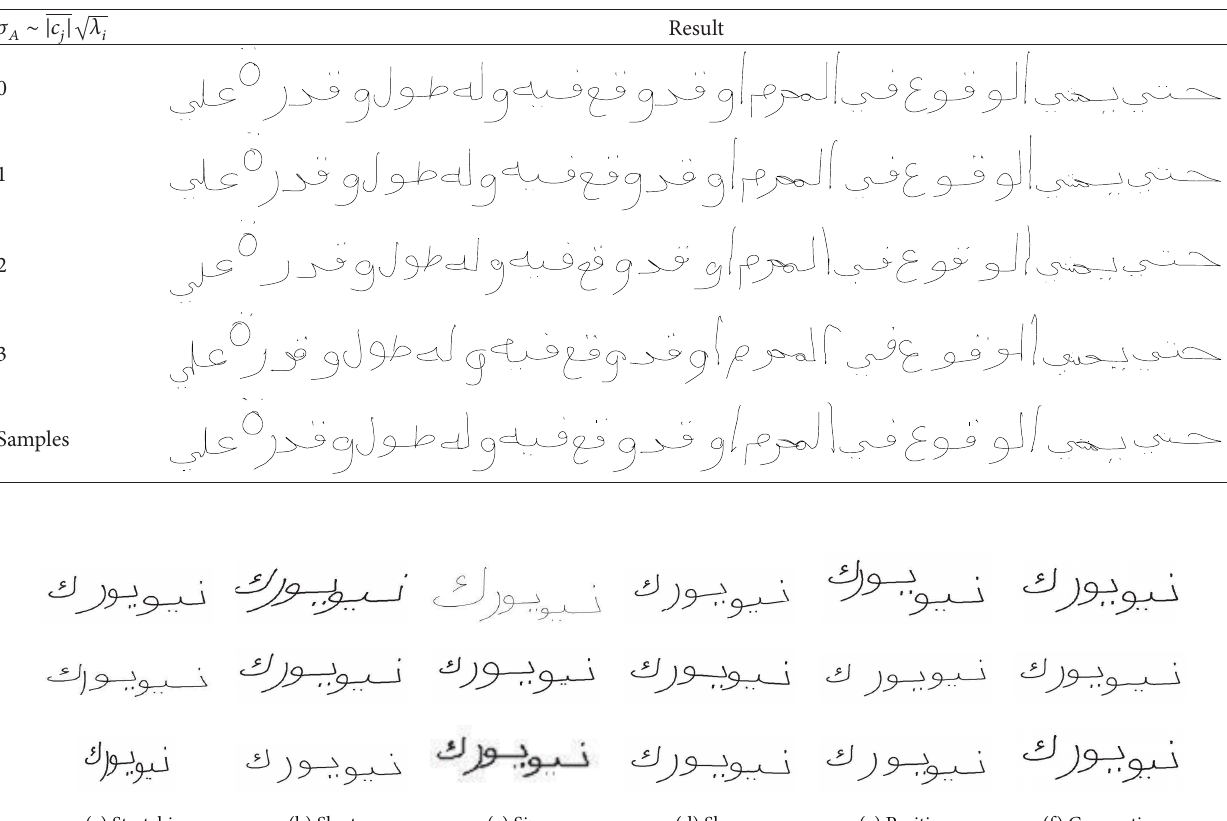
Table 3: Syntheses using ASMs and sample based glyphs of writer 1.